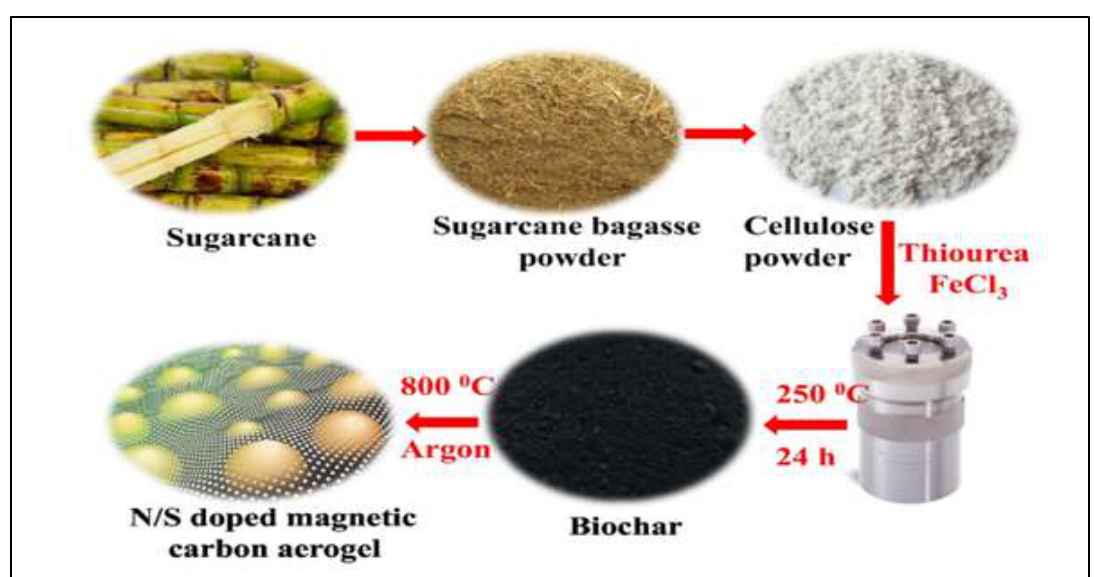
Figure 9. The fabrication of N/S doped carbon aerogel by using sugarcane bagasse for bisphenol-A absorption. Adapted from Ahamad et al. [125] .